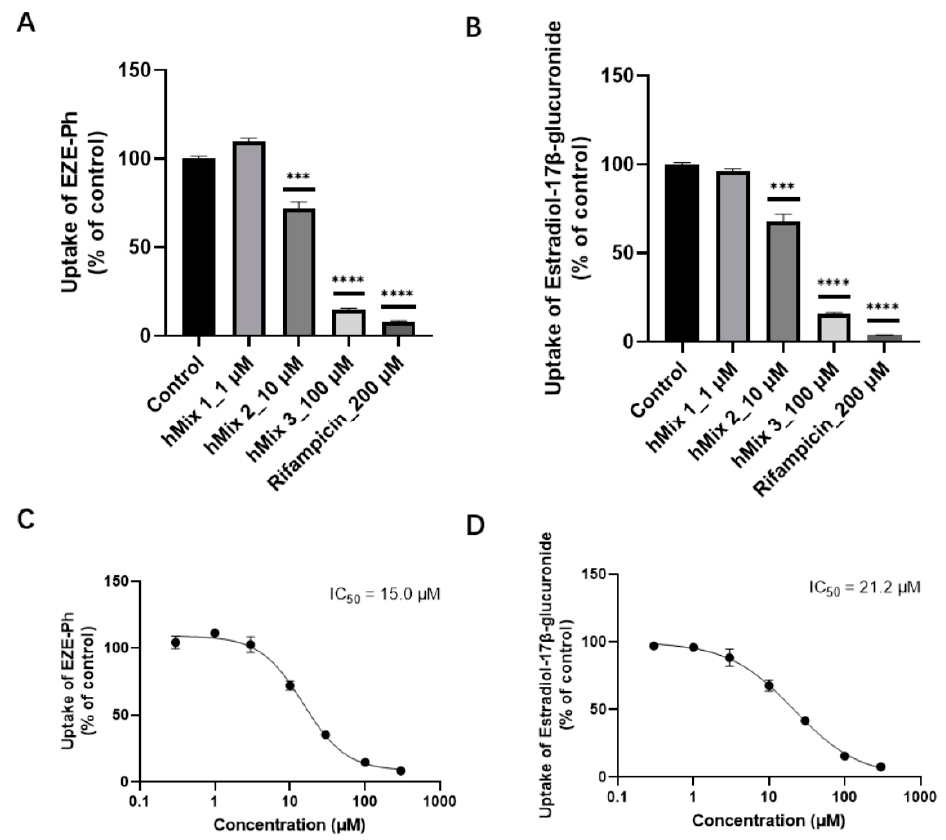
Figure 10. Inhibitory effects of bile acid mixtures and rifampicin on EZE-Ph ( A ) and estradiol-17 β - glucuronide ( B ) uptake in OATP1B3-expressing HEK293 cells, and OATP1B3-mediated uptake of 10 µ M EZE-Ph over 5 min ( C ) and uptake of 5 µ M estradiol-17 β -glucuronide over 4 min ( D ) in the absence and presence of bile acid mixtures. OATP1B3-mediated EZE-Ph and estradiol-17 β - glucuronide accumulations were corrected by subtracting the nonspecific accumulation in mock- transfected HEK293 cells from that in OATP1B3-expressing HEK293 cells. The values were expressed as a percentage of the uptake in the absence of bile acid mixtures. Solid lines represent the fitted line obtained by nonlinear regression analysis. Data are expressed as mean ± S.D. ( n = 3). *** p < 0.001 and **** p < 0.0001 compared with control.